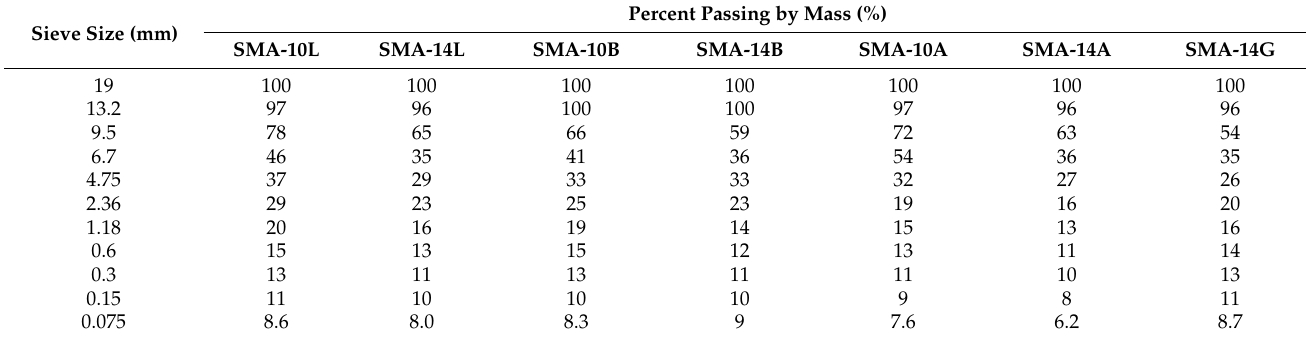
Table 7. SMA mixture gradation results.